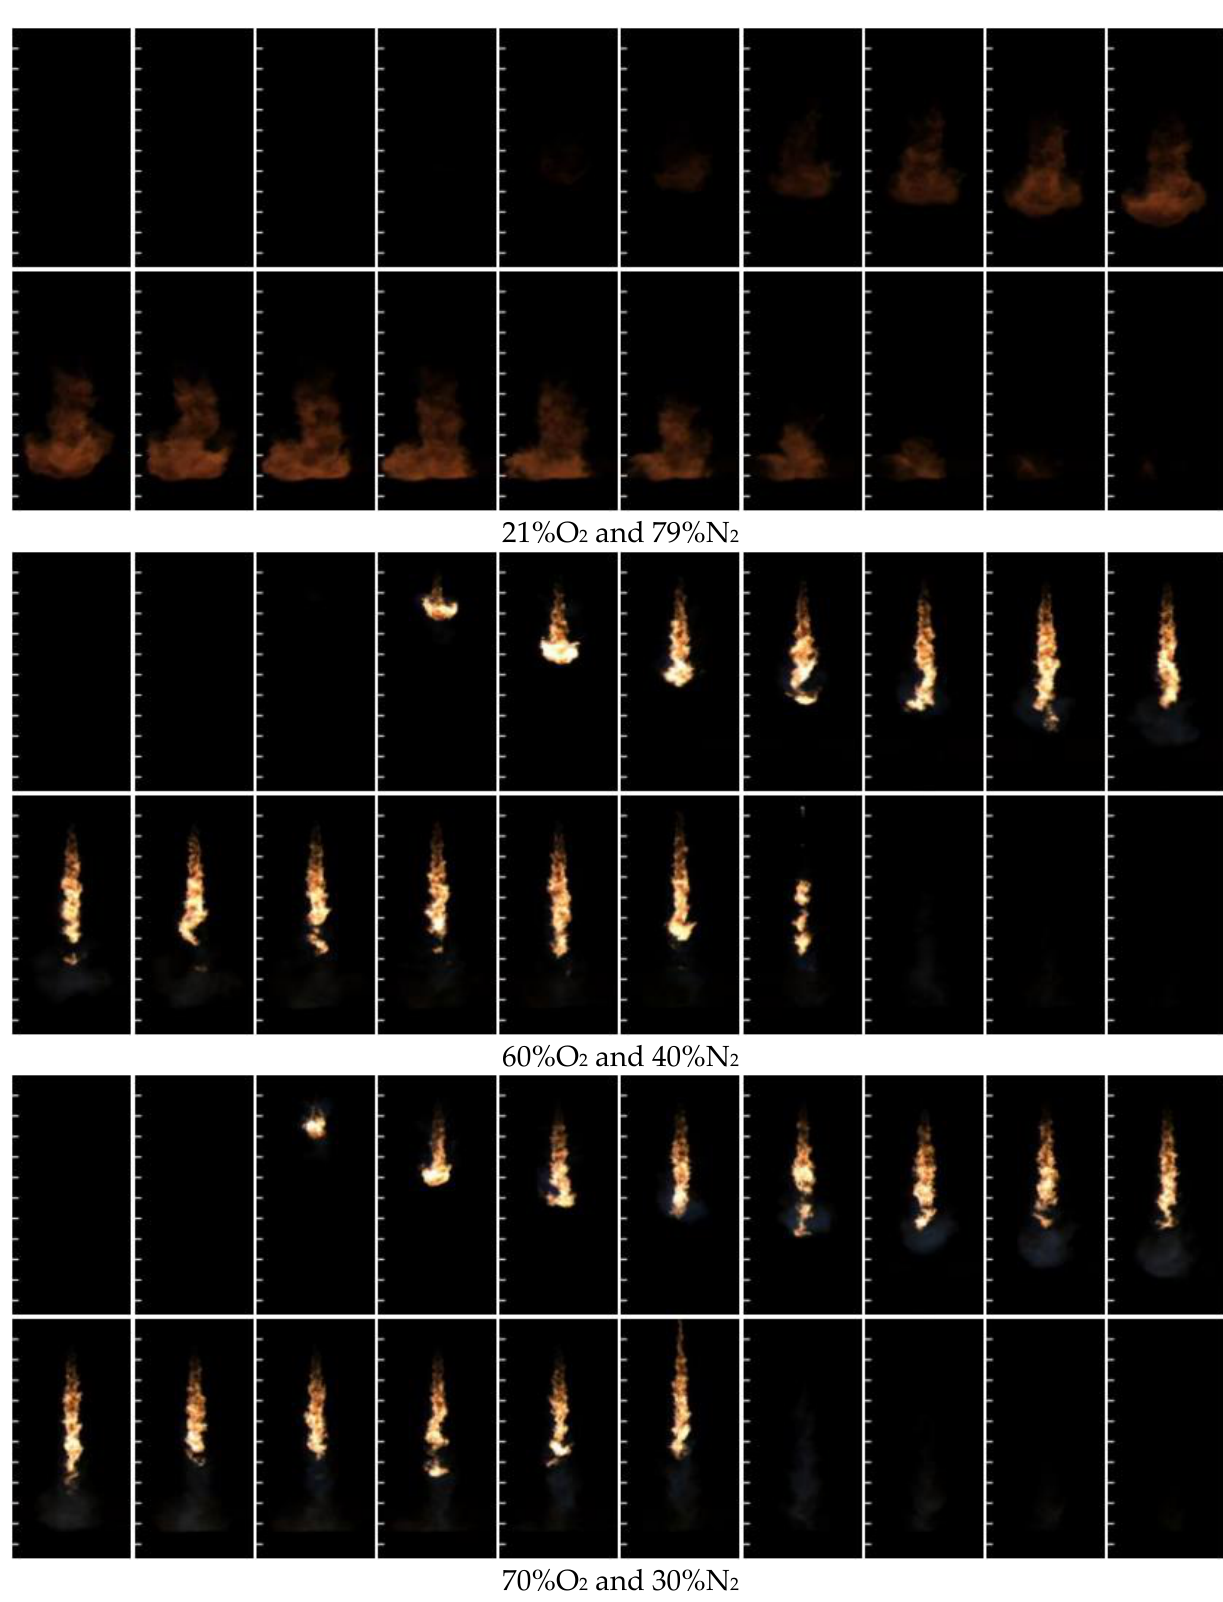
Figure 2. Comparison of combustion flames under different low-nitrogen